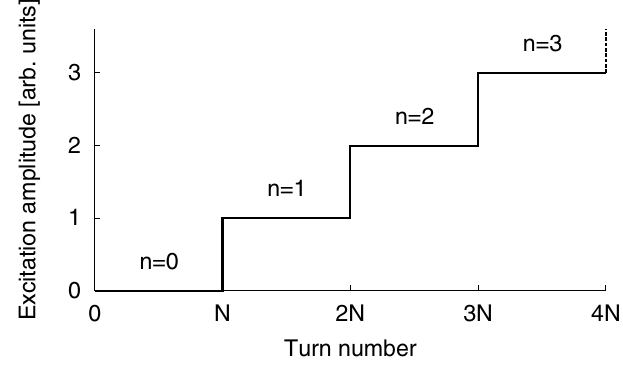
FIG. 1. Excitation amplitude of the ac dipole versus turn